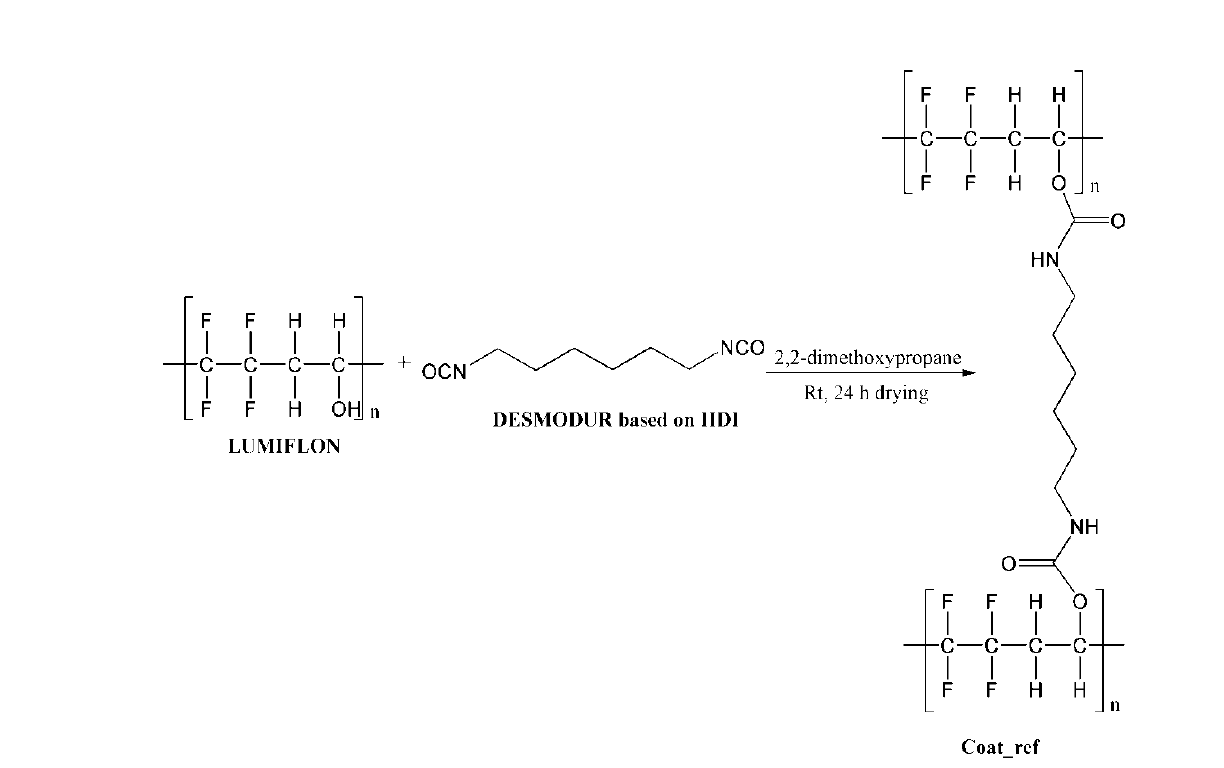
Figure 3. Schematic presentation of chemical reaction during coating preparation.